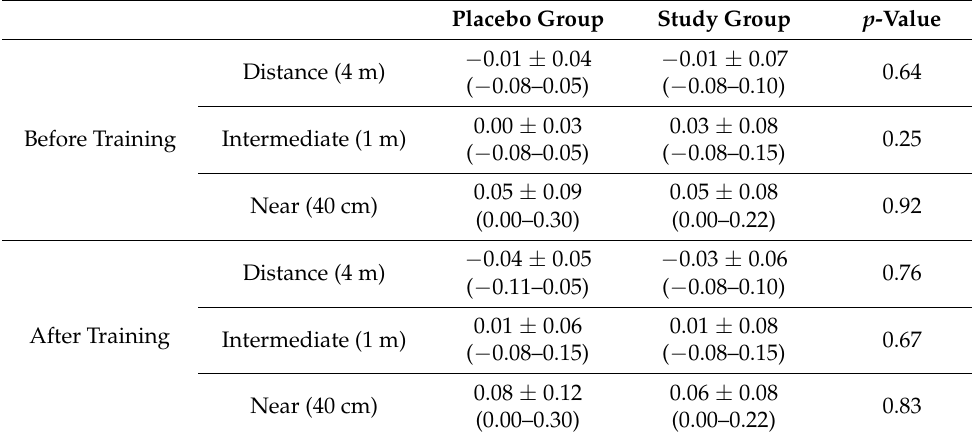
Table 2. Binocular VA characteristics of both groups before the training. Mean ± standard deviation (minimum and maximum) values for distance, intermediate, and near vision are represented by groups. Differences between groups were assessed by the Mann–Whitney test, and statistically sig- nificant differences ( p < 0.05) are marked with an asterisk (*). Distance, intermediate, and near vision were assessed at 4 m, 1 m, and 40 cm, respectively.